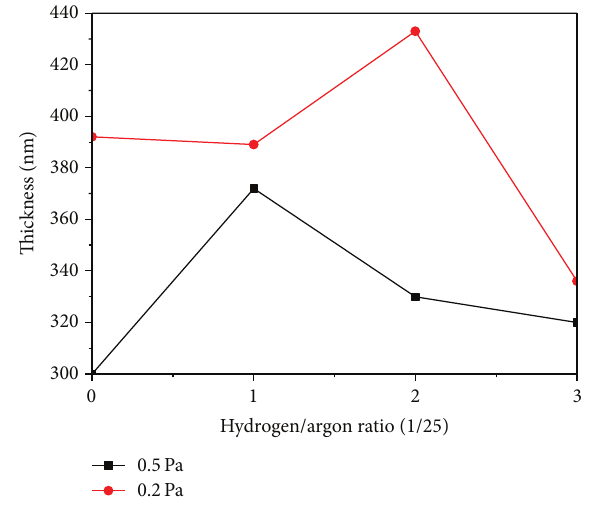
Figure 1: Thickness of the ZnS thin films deposited at varied sputtering